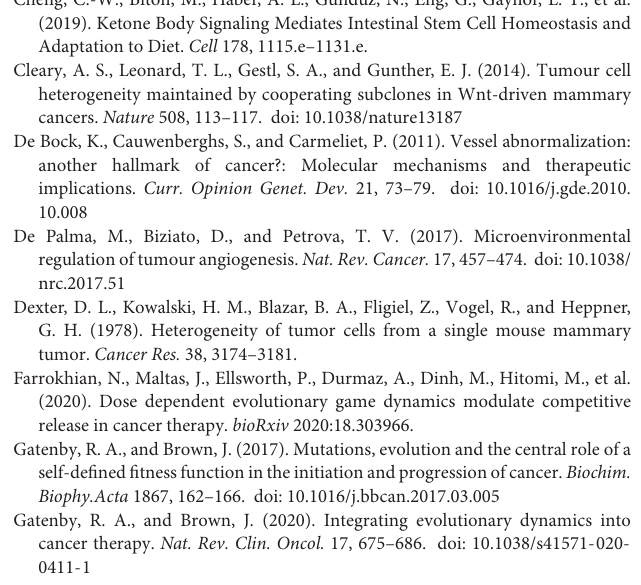
Supplementary Figure 4 | (A) Expression levels of the slc16A family transporter genes in 168FARN. RT-QPCR analysis was performed on 168FARN RNA for Mct2, Mct1, Mct3, and Mct4 genes and normalized to HPRT. Relative expression levels were compared to Mct2. (B) Slc16A1 expression in both subclones. Slc16A1 RNA levels were monitored by RT-QPCR, normalized with HPRT and adjusted relative to levels in 168FARN cells. (C) Influence of Slc16A1 expression by β -hydroxybutyrate. Experiment was performed as in Figure 5B . Slc16A1 RNA levels were quantified as in panel (A) and adjusted relative to levels in control condition. ∗∗∗ p < 0.001. Supplementary Figure 5 | (A) Mean net growth rate difference (gain function) versus initial 4T07 proportion in phases 1 and 2 (purple) and phases 1, 2, and 3 (green). Each point corresponds to the outcome of a competition assay. Regression lines are shown with 95% confidence intervals. (B) Mean net growth rate difference versus initial 4T07 proportion in phase 2 (purple) and phases 2 and 3 (green). This data set was obtained from the data shown in panel (A) by adjusting for exponential growth in phase 1 (see section “Materials and Methods”). (C) The same as panel (A) but including results for the first round of competition assays (days 0–3). First-round measurements were excluded from analyses as they were unusually variable and unreliable due to an experimental artifact (see section “Materials and Methods”). (D) The same as panel (B) but including results for the first round of competition assays (days 0–3). Supplementary Figure 6 | Relationship between population dynamics and net growth rates. The net growth rate of each cell type (right column) is the derivative of its log-transformed growth curve (left column). (A) Mathematical model dynamics. From the dynamical model, net growth rates can be found precisely by evaluating differential equation terms. The model was parameterized with values inferred from data ( Table 1 ) and initiated with a 3:1 ratio of 168–4T07. (B) Empirical dynamics. From time-lapse data, net growth rates can be approximated as local gradients (difference quotients). In this example, we estimated net growth rates from smoothed growth curves by calculating difference quotients across a 5-h span. Smoothed growth curves (not shown) were obtained by computing running medians with a 5-h span. Since we did not use heterotypic time-lapse data for parameter inference, the resemblance between the two rows of this figure contributes to validating our model. The data in panel (B) is the same as in Figures 3A,B . Supplementary Figure 7 | Mathematical relationships relevant to our methods. The diagram illustrates several equivalent ways of calculating the mean growth rate difference (gain function, blue) from the parameterized dynamical model (red). Also shown is our method of calculating the gain function from competition assay data